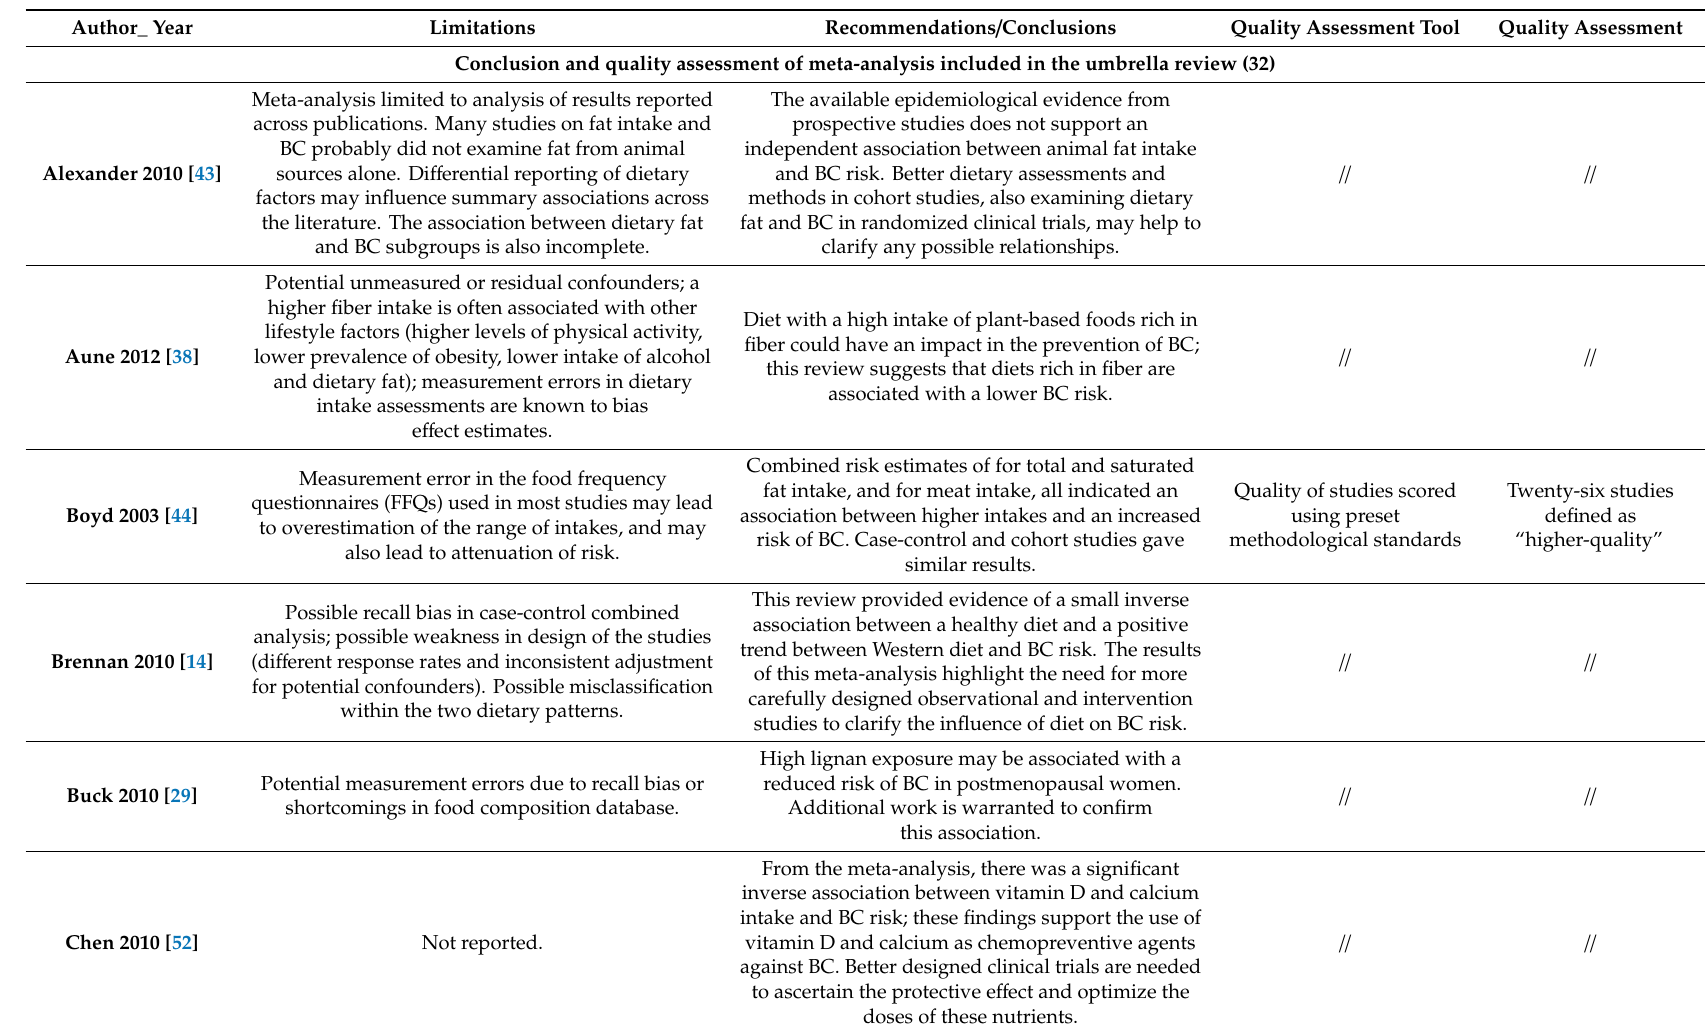
Table 3. Conclusions and limitations of studies included in the umbrella